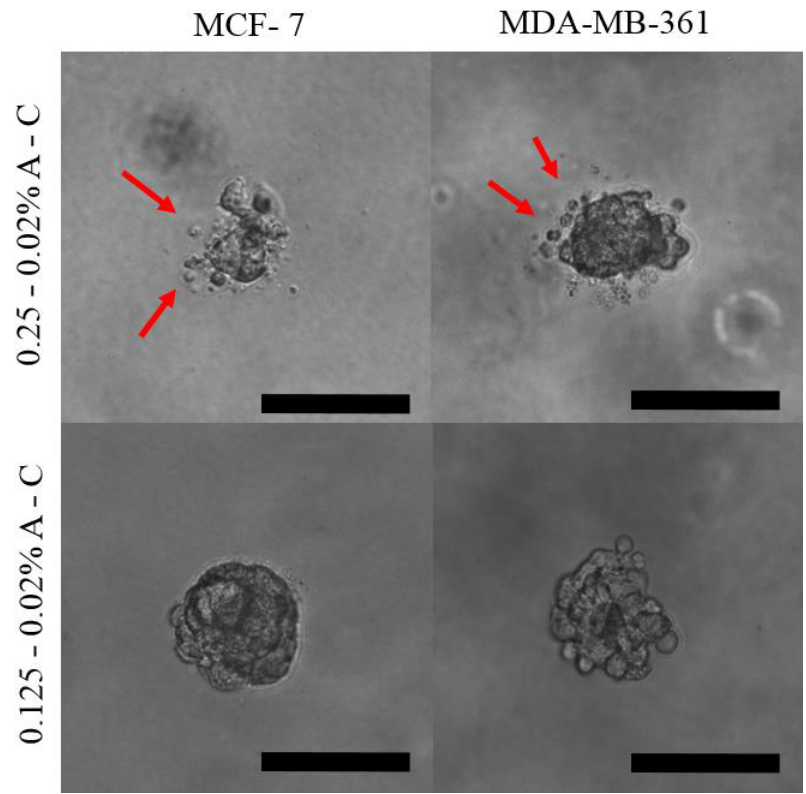
Figure 5. Optical images of the tumor spheroids obtained by MCF-7 and MDA-MB-361 cells after growing for 8 days in either 0.125–0.02% ( top ) or 0.25–0.02% A-C hydrogels ( bottom ). The red arrows point to the cells disseminated by the spheroids grown in the soft matrix. Scale bar is 100 µm.